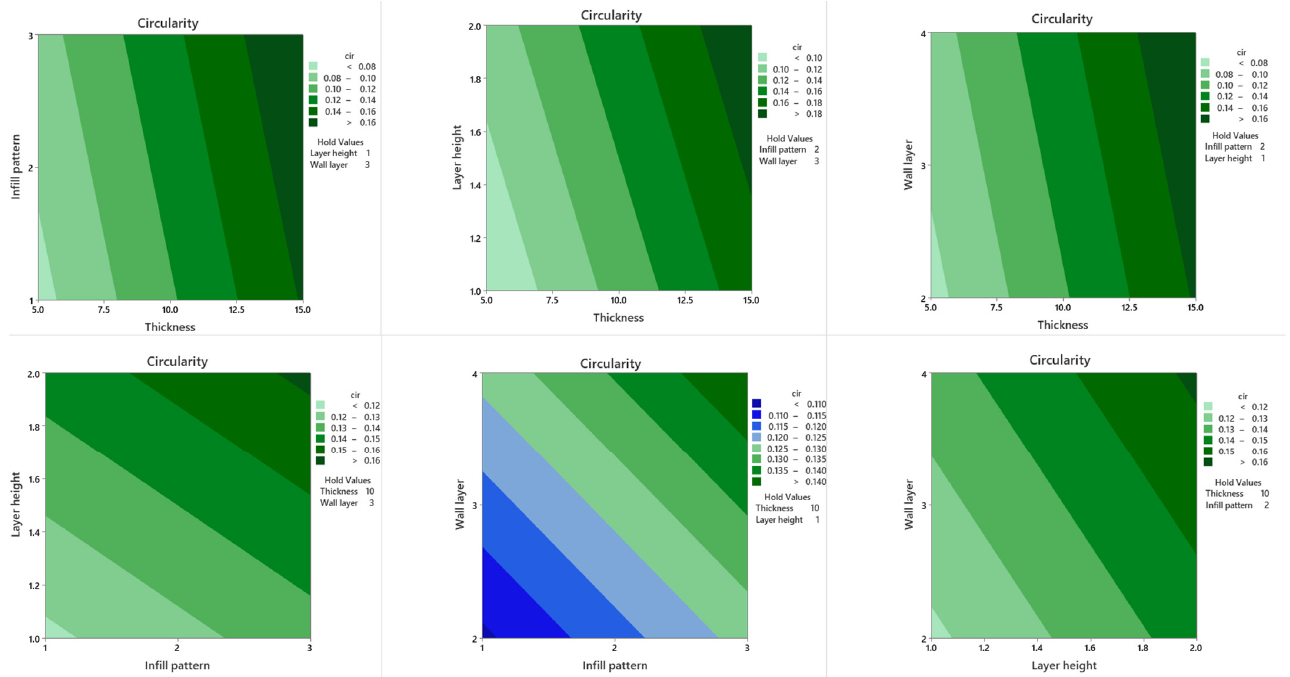
Figure 9. Circularity contour plots.